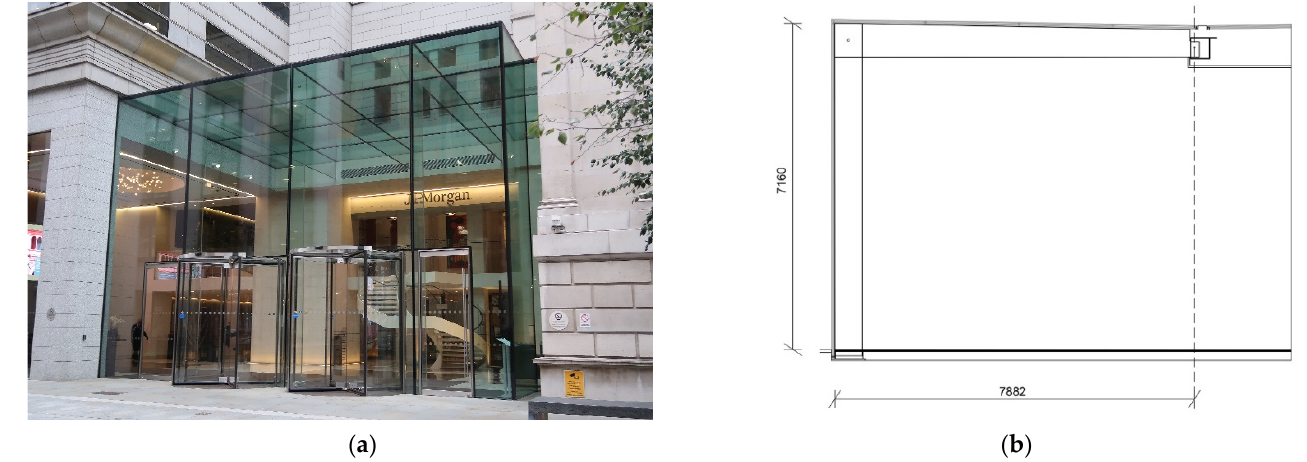
Figure 22. The 60 Victoria Embankment in London: ( a ) view from John Carpenter Street (photo by the author); ( b ) geometry of glass frame (figure by the author).